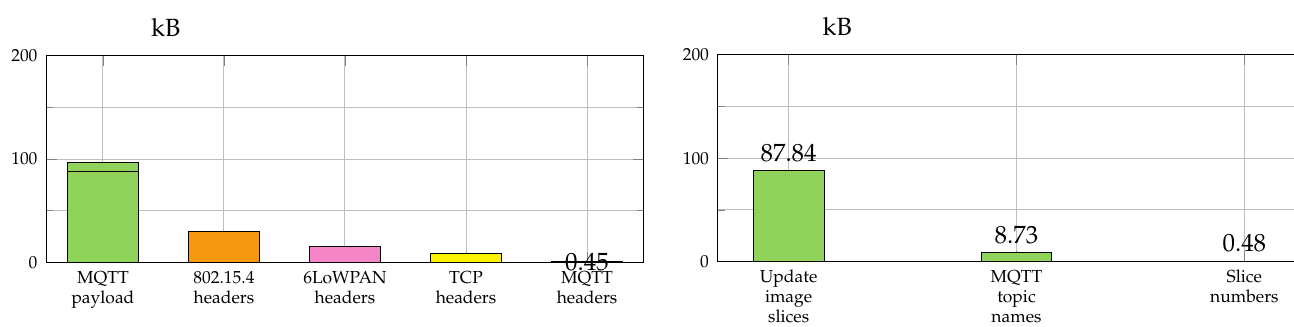
Figure 7. Analysis of the network traffic captured during the transmission of an update image file with a size of 87.8 kB using a slice size of 220 bytes.